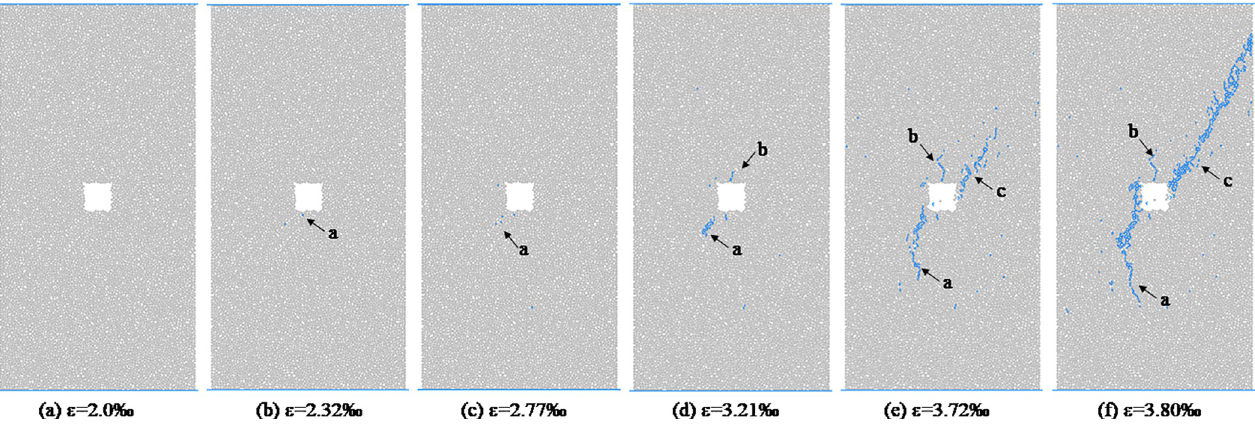
Fig 13. Meso-damage process of coal and rock with square hole defect.